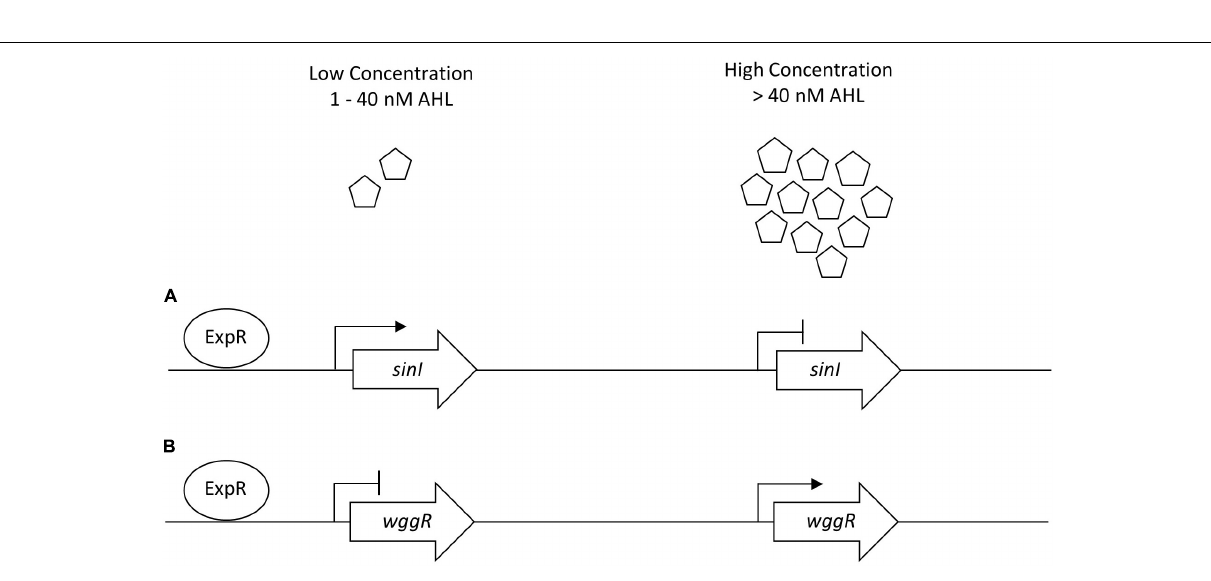
Frontiers in Microbiology |